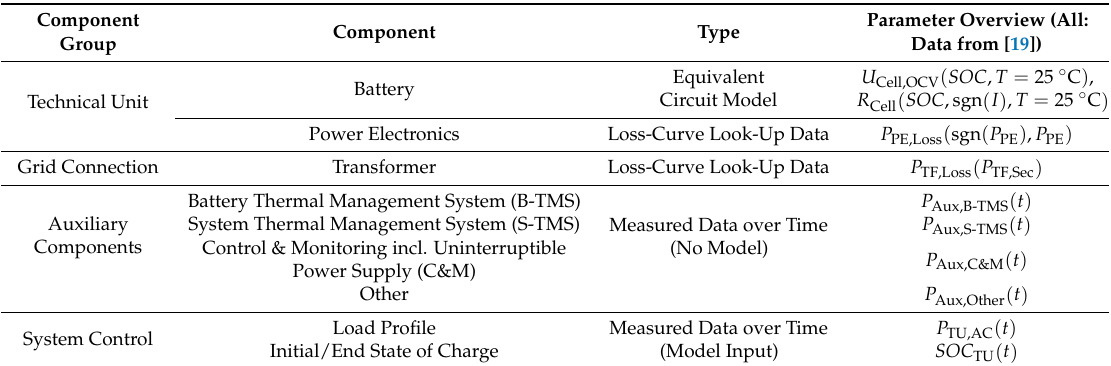
Table 1. Component model overview.